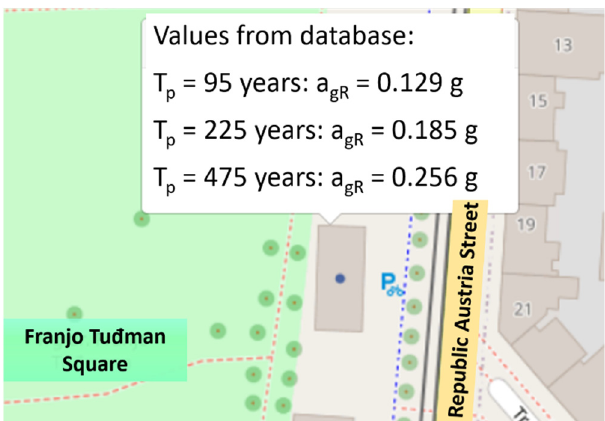
Figure 13. Peak ground acceleration values for the location of the building (from [36]—Croatian National Annex of EN1998).